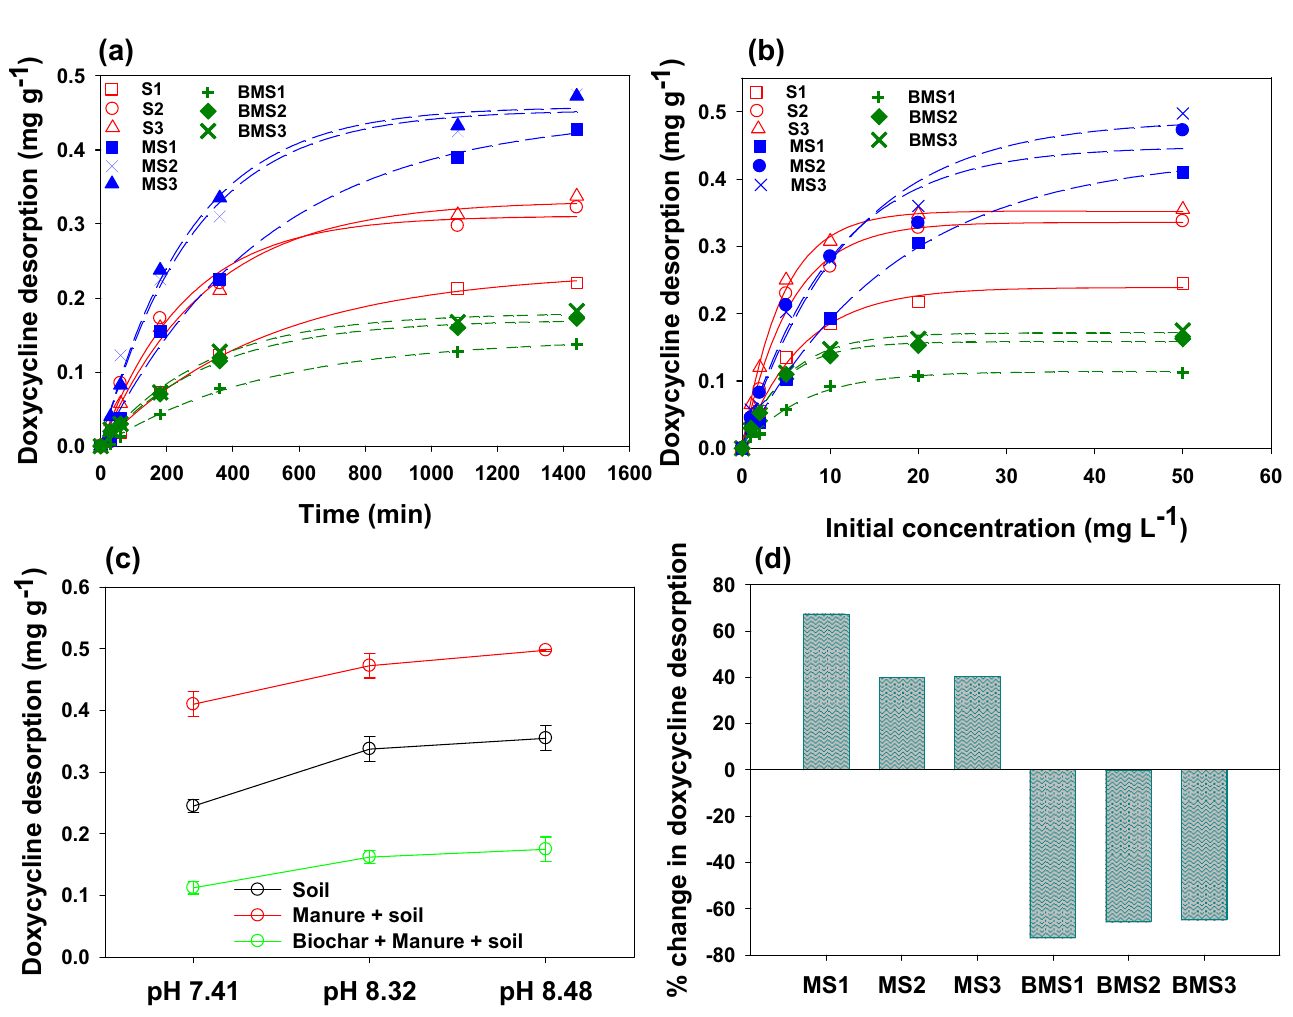
Figure 6. Effects of contact time ( a ), initial concentration ( b ), and soil pH ( c ) on doxycycline desorption from different soils (pH 7.41 (S1), pH 8.32 (S2), and pH 8.48 (S3)), manure + S1 (MS1), manure + S2 (MS2), manure + S3 (MS3), mesquite wood-waste-derived biochar + MS1 (BMS1), mesquite wood-waste-derived biochar + MS2 (BMS2), and mesquite wood-waste-derived biochar + MS3 (BMS3), as well as percent increase/decrease in doxycycline desorption from soils S1, S2, and S3 after the addition of manure and manure + mesquite wood-waste-derived biochar ( d ).